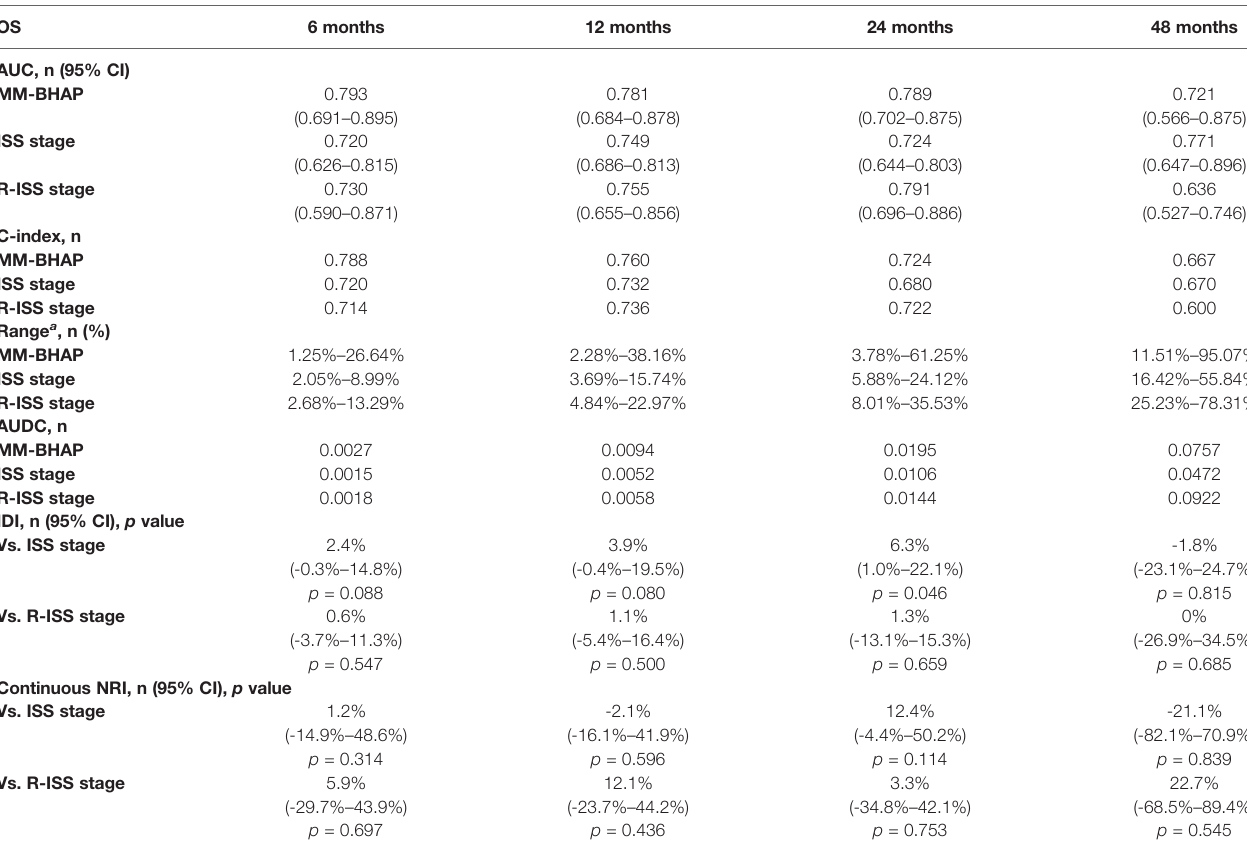
TABLE 3 | Comprehensive evaluations of the different models in the development cohort.